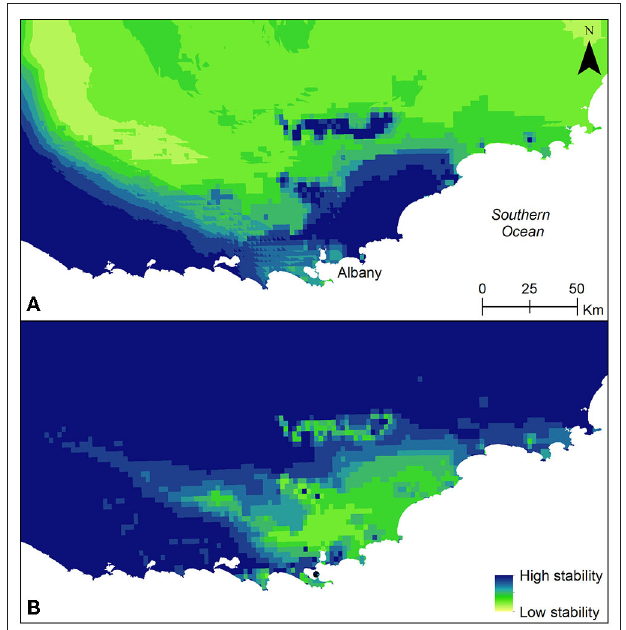
FIGURE 3 | Climatic stability for B. brownii (A) in the past, between the LGM and present, and (B) in the future, between present and projected for 2070.